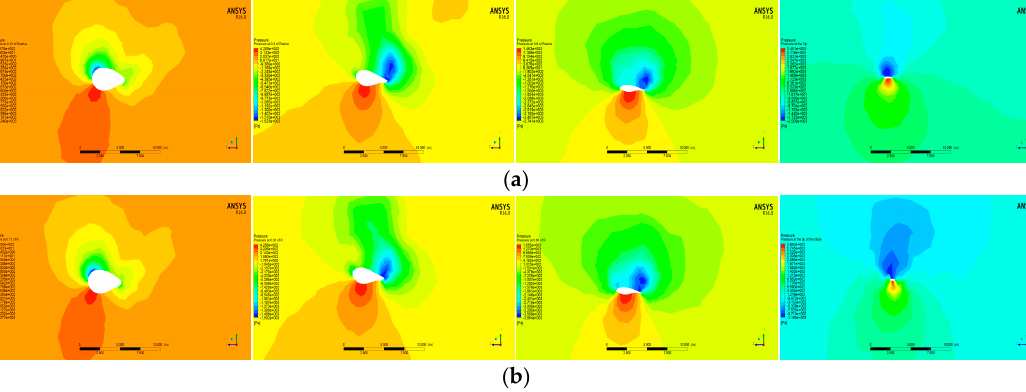
Figure 12. Velocity contour, uni-directional ( a ) and bi-directional ( b ) coupling at the end of 5 s.